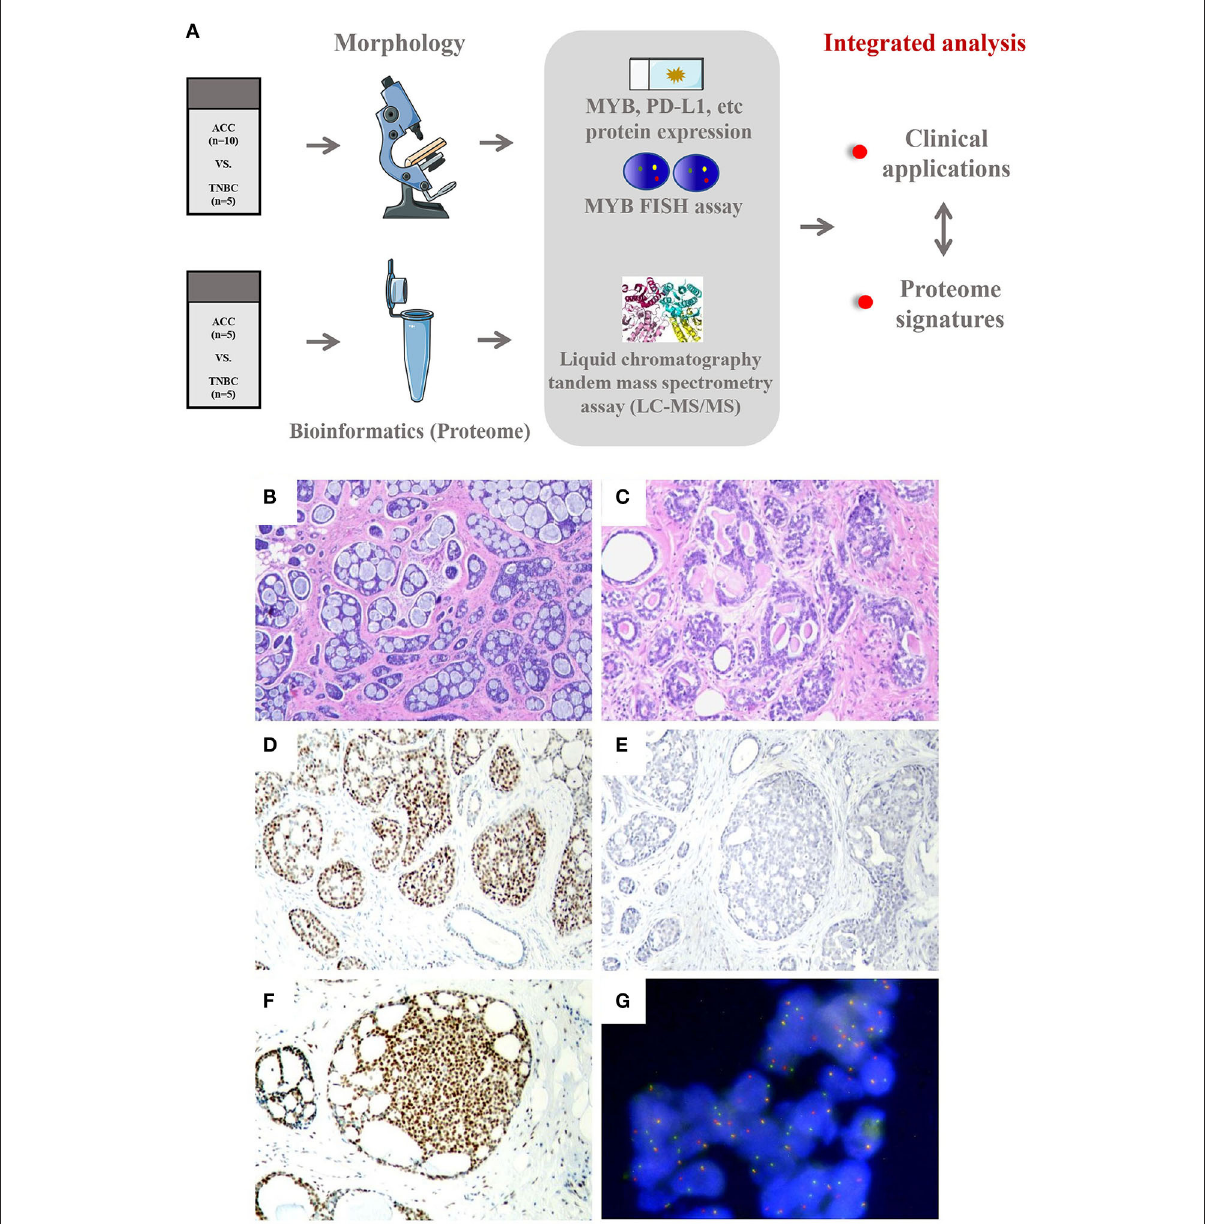
FIGURE1 (A) Workflow of integrated analysis of ACC compared with BL-TNBC. (B–G) Histological, immunohistochemical, and MYB FISH results of ACC. (B) Adenoid cystic carcinomas predominantly demonstrating cribriform and tubular architecture (40 × ). (C) The basement membrane material inside the luminal of ACC gland (100 × ). (D) ACC is immunoreactive for Sox10 (100 × ). (E) ACC is completely negative for PD-L1 expression (CPS = 0 on Dako 22C3 platform) (100 × ). (F) ACC showing strong nuclear immunoreactive for MYB (100 × ). (G) Rearrangements of MYB detected by FISH using dual-color break-apart probe (400 ×